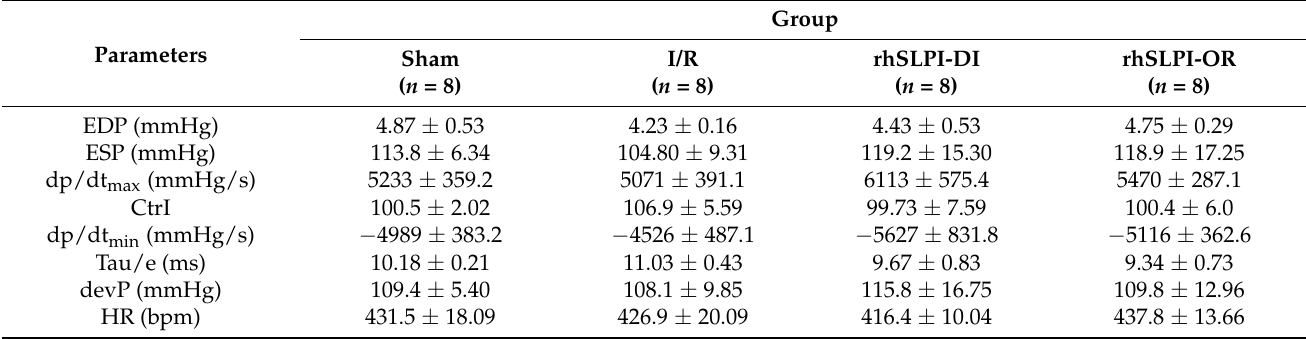
Table 1. The baseline parameters of left ventricular pressure (LVP) determined the effect of rhSLPI on the LVP parameters in I/R (baseline).